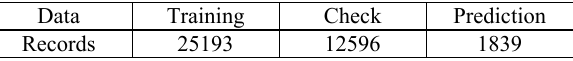
Table 2. Landslide records of analytical data